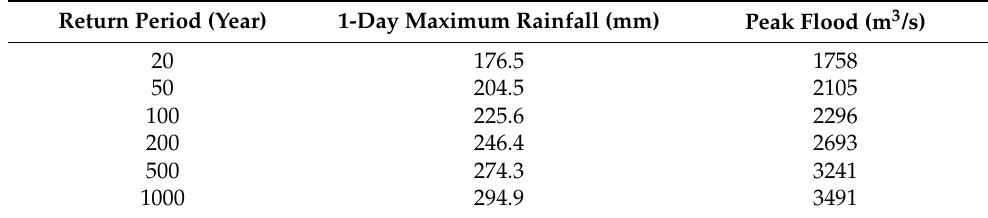
Table A1. Design flood for different return periods at the Swa Dam site, Yedashe Township (IWUMD).